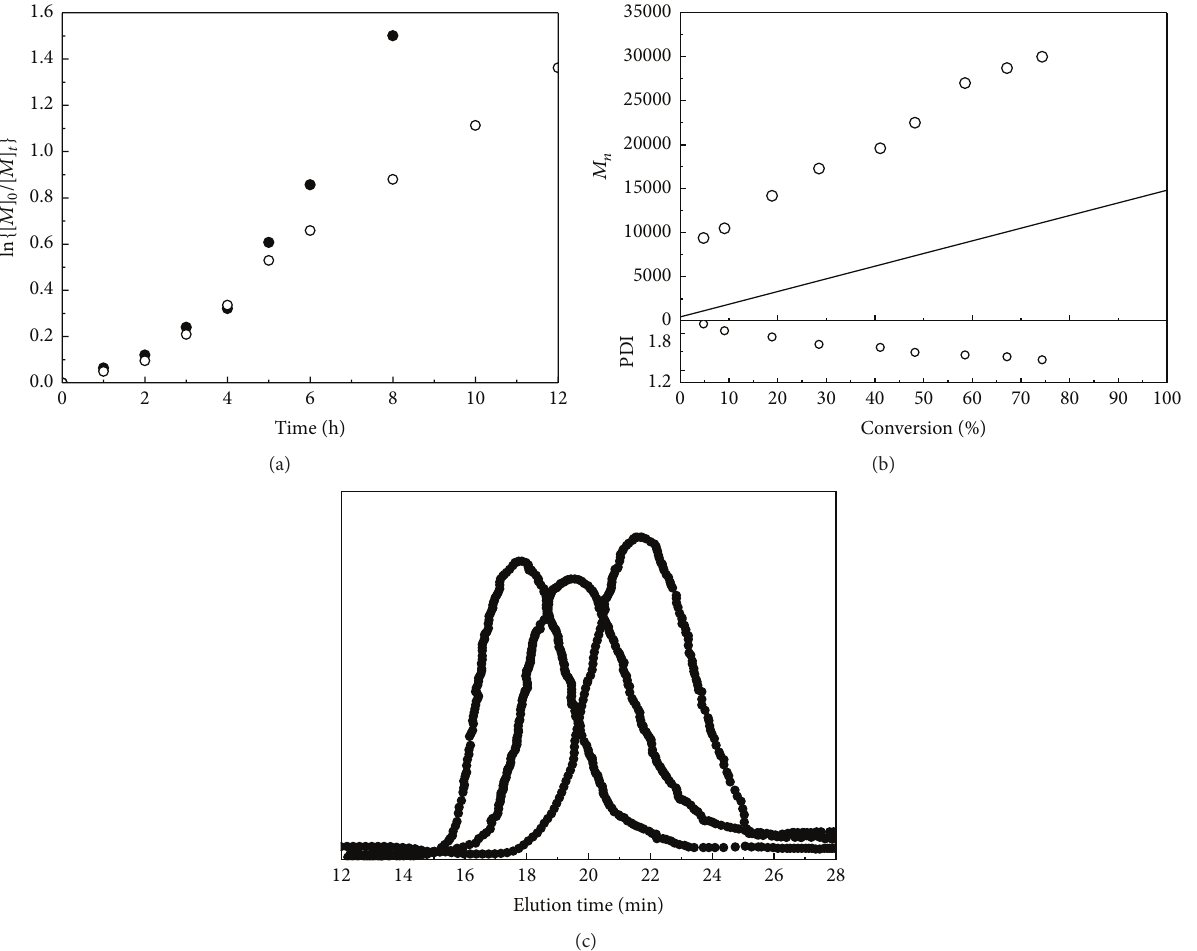
Figure 4: Photopolymerization of MMA in the presence of photosensitive alkoxyamine, light intensity = 20 mW/cm 2 , [MMA] = 9.42 mmol, [PE-TEMPO-Q] = ( e ) 2.19 × 10 −2 mmol or ( I ) 6.56 × 10 −2 mmol. (a) Kinetics plot; (b) plots of molecular weights and distributions versus conversion, the solid line corresponds to theoretical 𝑀 𝑛 ; (c) GPC traces of the MMA homopolymers at different conversion: Table 1, runs 9, 12, and 15 ([PE-TEMPO-Q] = 6.56 × 10 −2